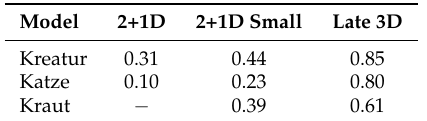
Table 4. Vision: ALC performance of the evaluated video classification models for the various video